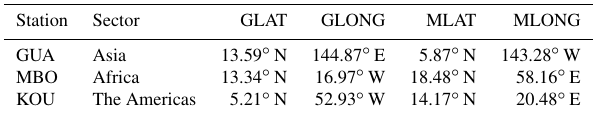
Table 2. Locations of the magnetometers used in the analysis. Station Sector